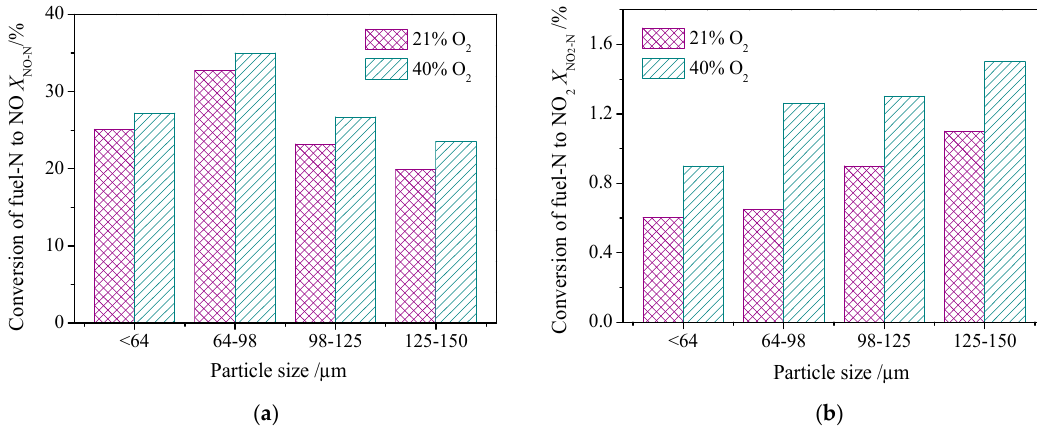
Figure 7. The particle size dependence of NO and NO 2 emissions at 1200 °C under the oxy-fuel condition. ( a ) Conversion to NO; ( b ) Conversion to NO 2 .